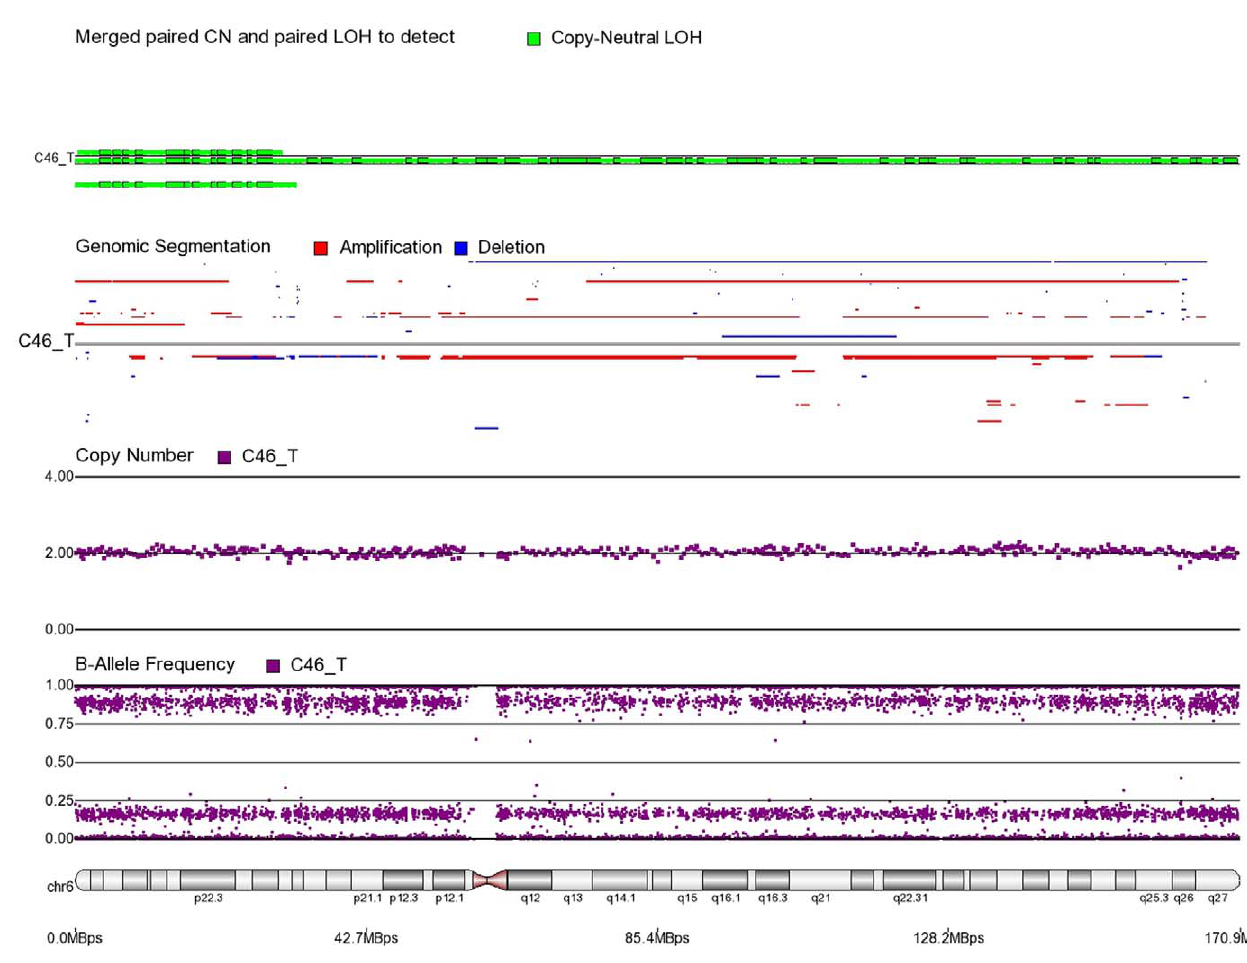
Figure 9. Mosaic cnLOH in chromosome 6 of CRC tissue sample C46_T. The cnLOH occurs in the entire chromosome.